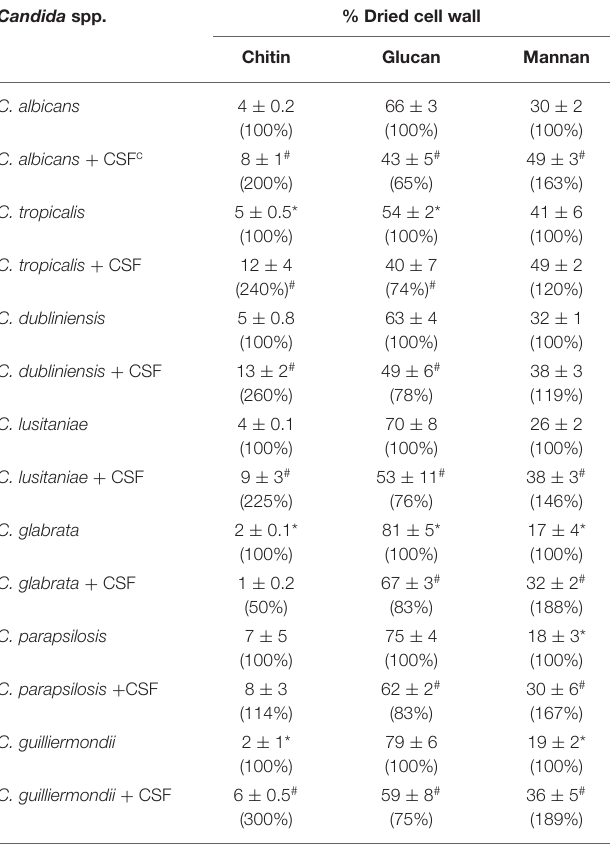
TABLE 4 | Quantification of the components of the cell wall of Candida species, with and without caspofungin treatment a,b,c *#. Candida spp.